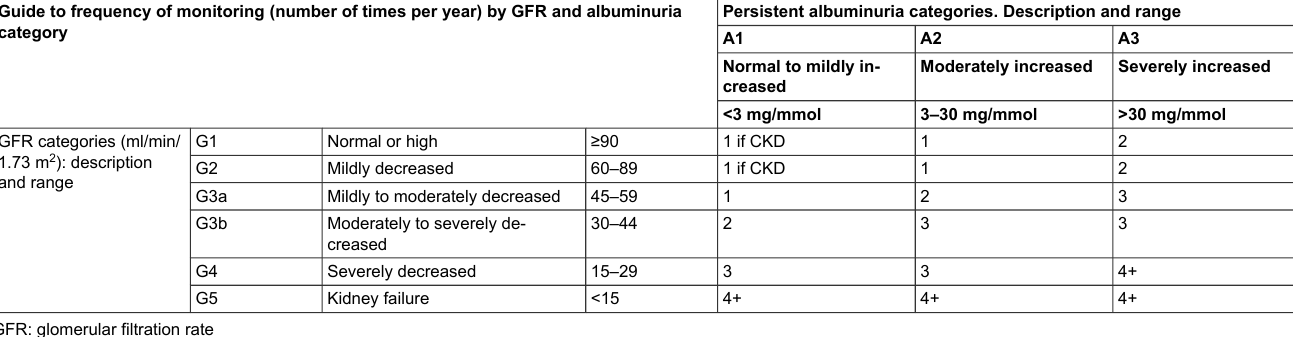
Persistent albuminuria categories. Description and